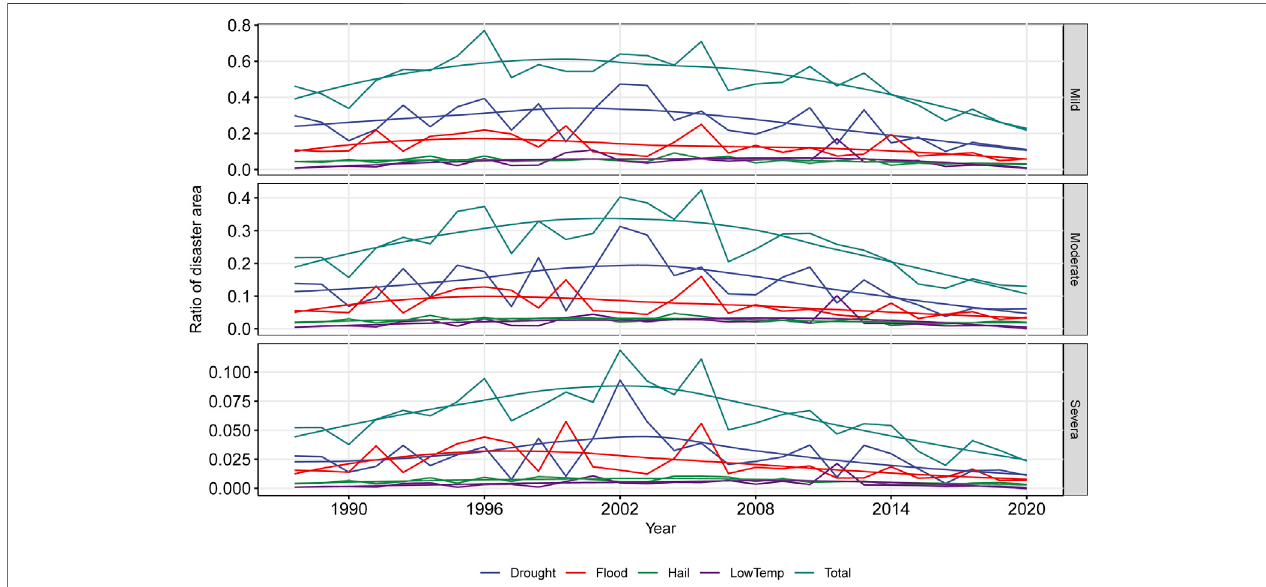
FIGURE 3 | Trends in the ratio of the area affected by each natural disaster type to the total cultivation area from 1988 to 2020. The smooth lines in each panel represent loss trends.